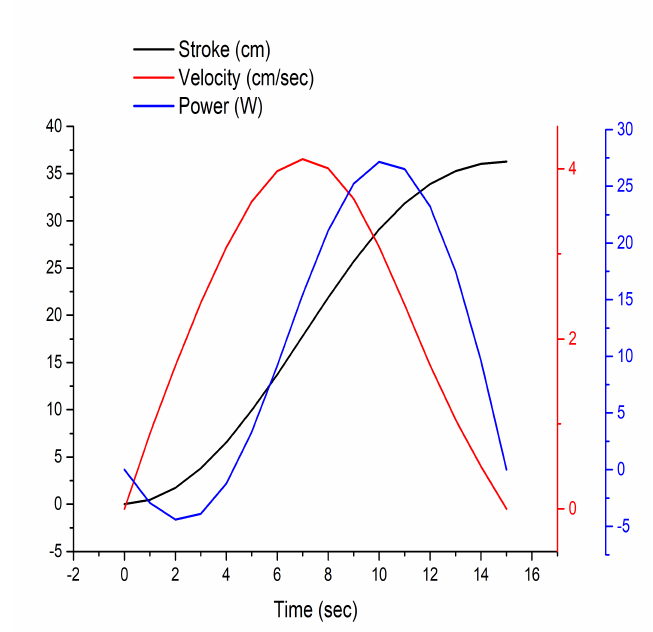
Figure 4. Analytical evaluation of Stroke, Velocity, and Power for Nose Landing